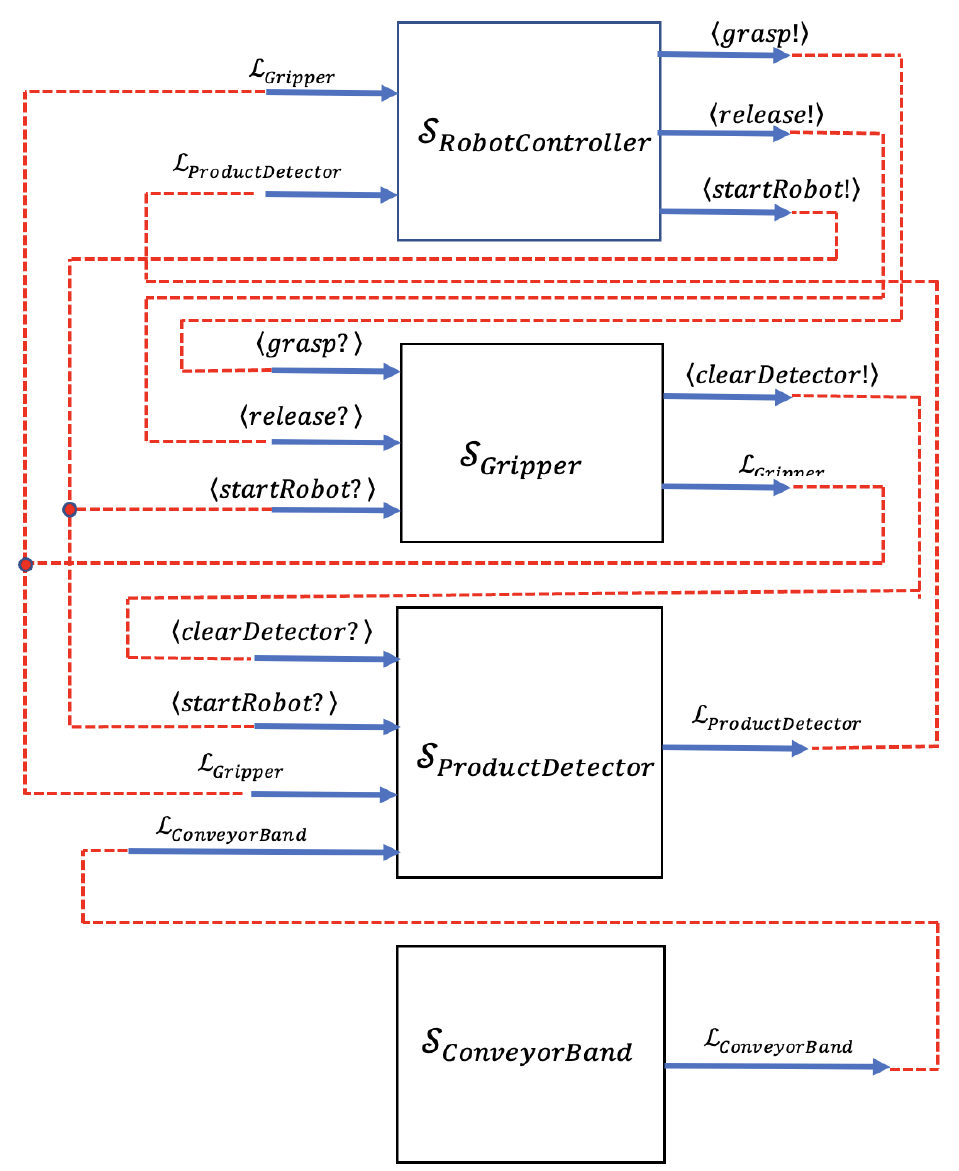
Figure 14. Block diagram of all modules.